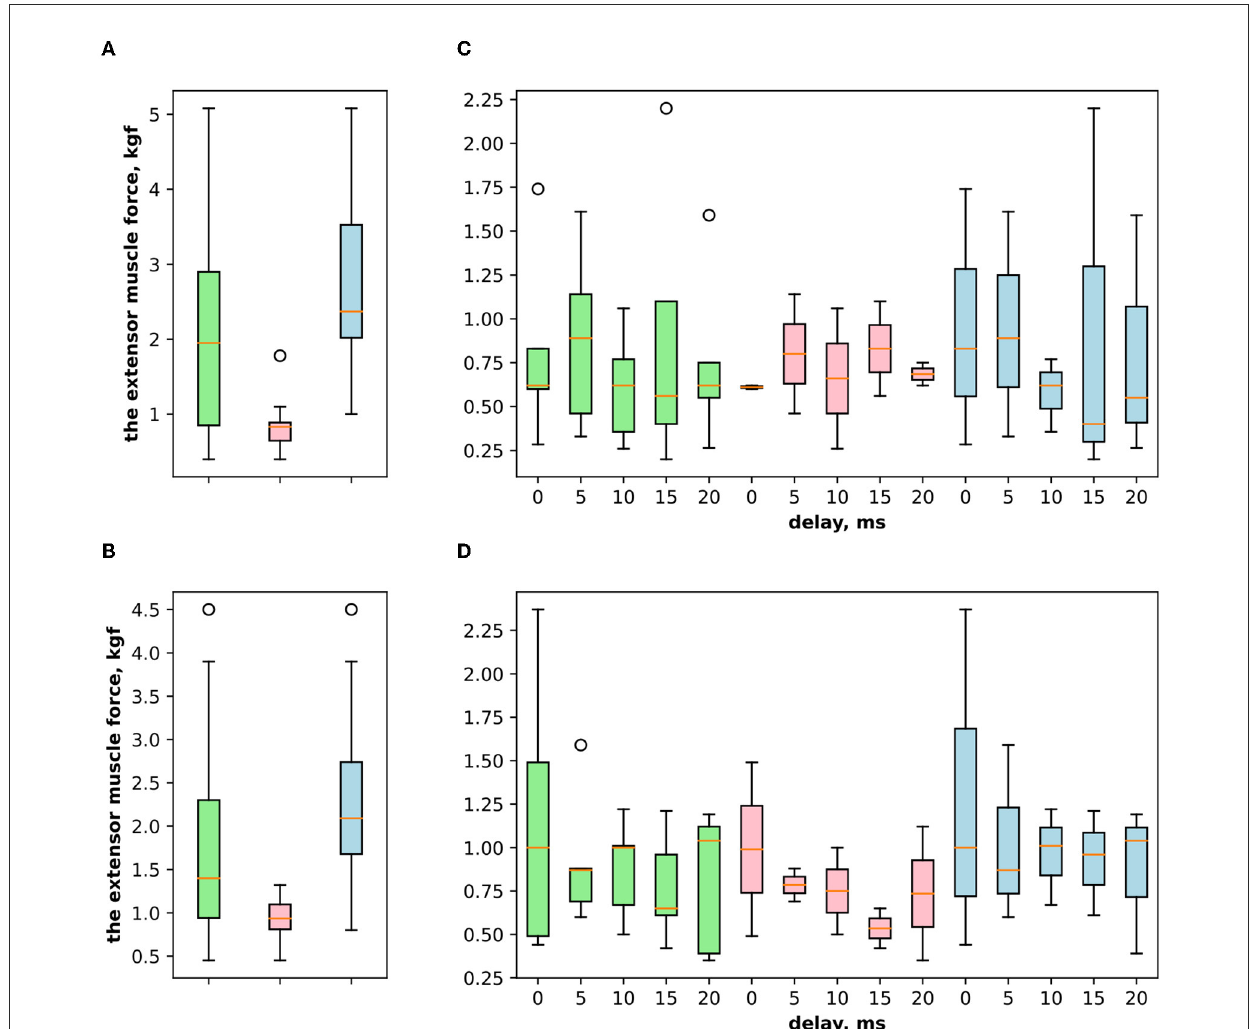
FIGURE5 (A) The extensor muscle force difference between voluntary activity and during antagonist muscle stimulation (inhibitory effect), where the green boxplot reflects the delta for both genders of volunteers (women and men) and pink reflects the delta for women and blue for men. (B) The extensor muscle force difference between voluntary activity and during the ulnar nerve stimulation (inhibitory effect). (C) The extensor muscle force difference between before antagonist muscle stimulation and during antagonist muscle stimulation (inhibitory effect) with the range of delays. (D) The extensor muscle force difference before antagonist nerve stimulation and during the ulnar nerve stimulation that innervates the flexor and triggers Ia afferent of the flexor, with the range of